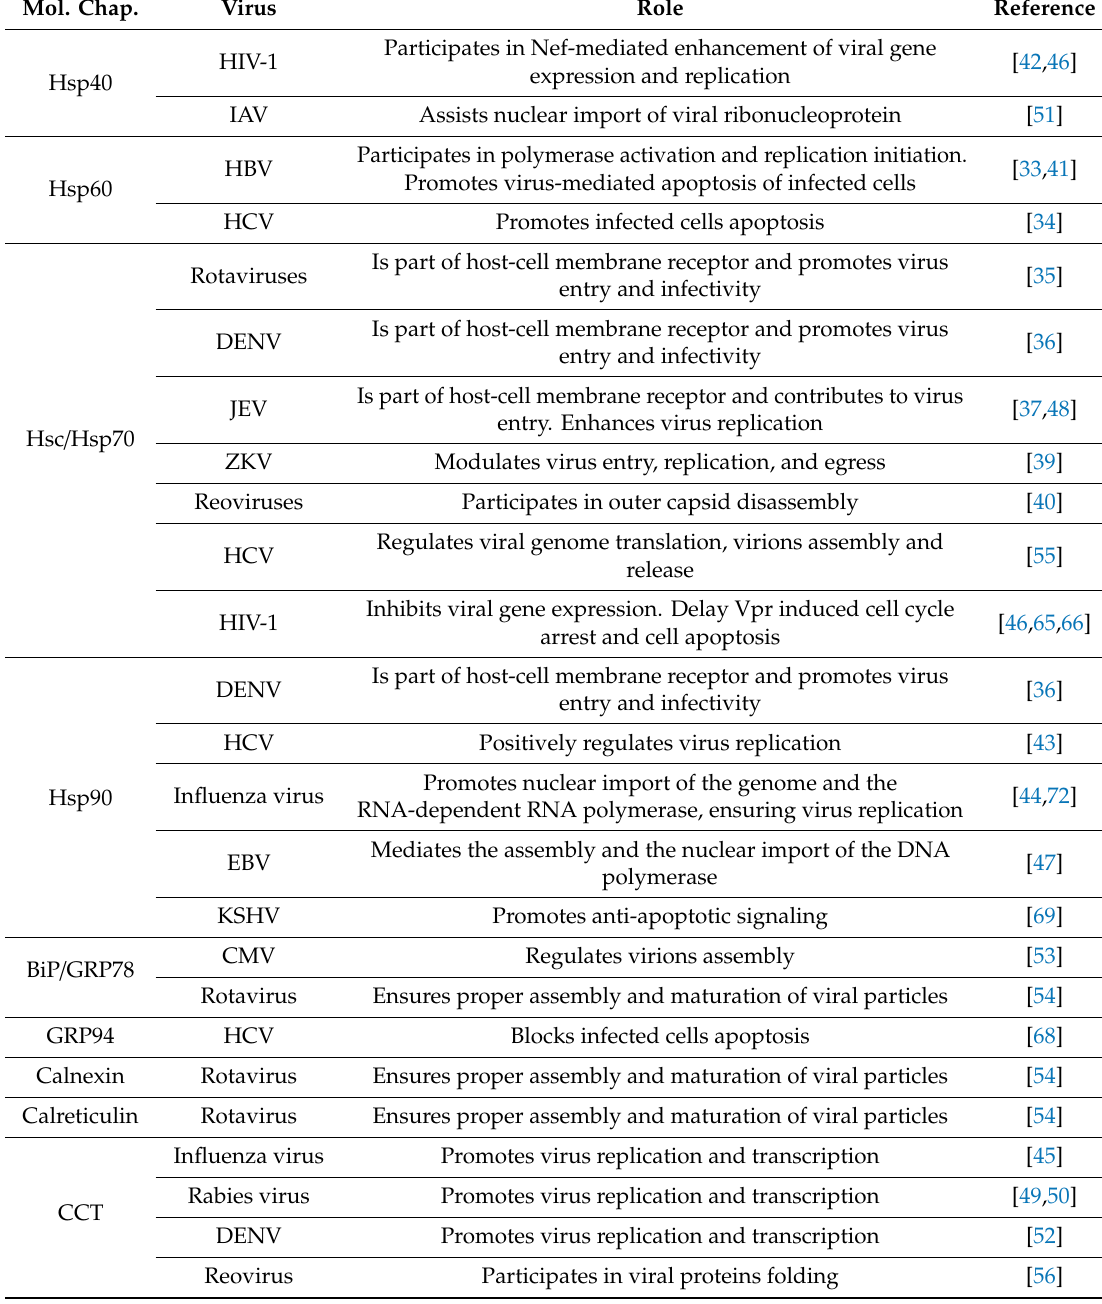
Table 1. Role of molecular chaperones in virus infections. Mol.